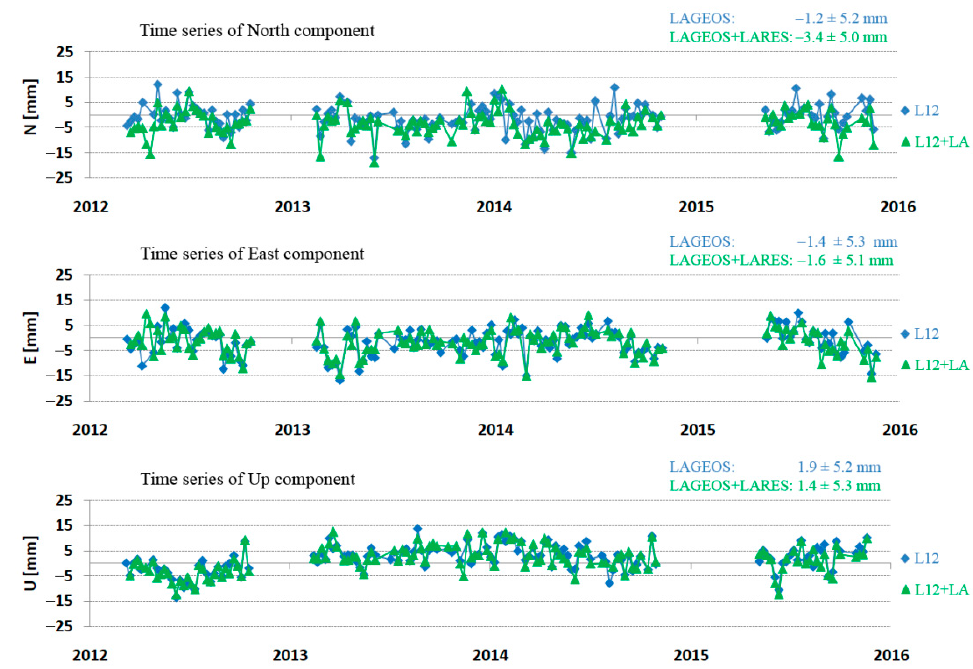
Figure 9. Time series of the North, East, and Up components for Zimmerwald station (7810) for LAGEOS + LARES (green) and LAGEOS (blue) in the period from 2012 to 2015.